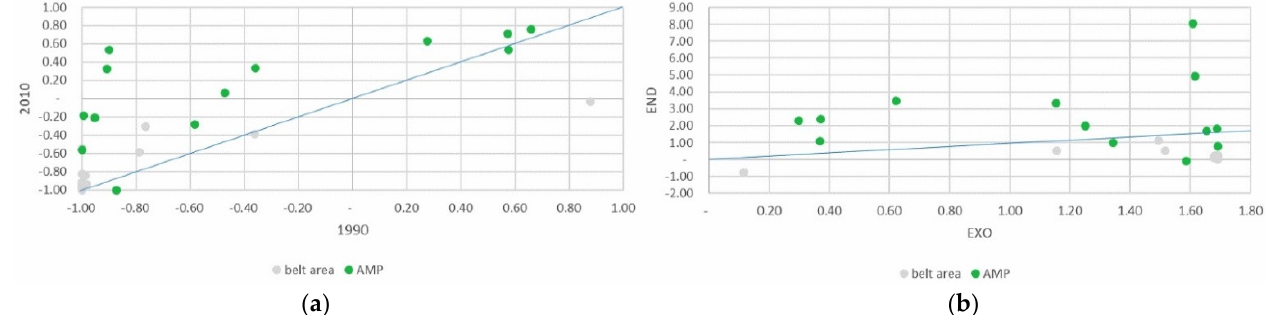
Figure 14. ( a , b ) PSI and DPSI for legumes. Source: Drawn up by the authors using data from the ISTAT.